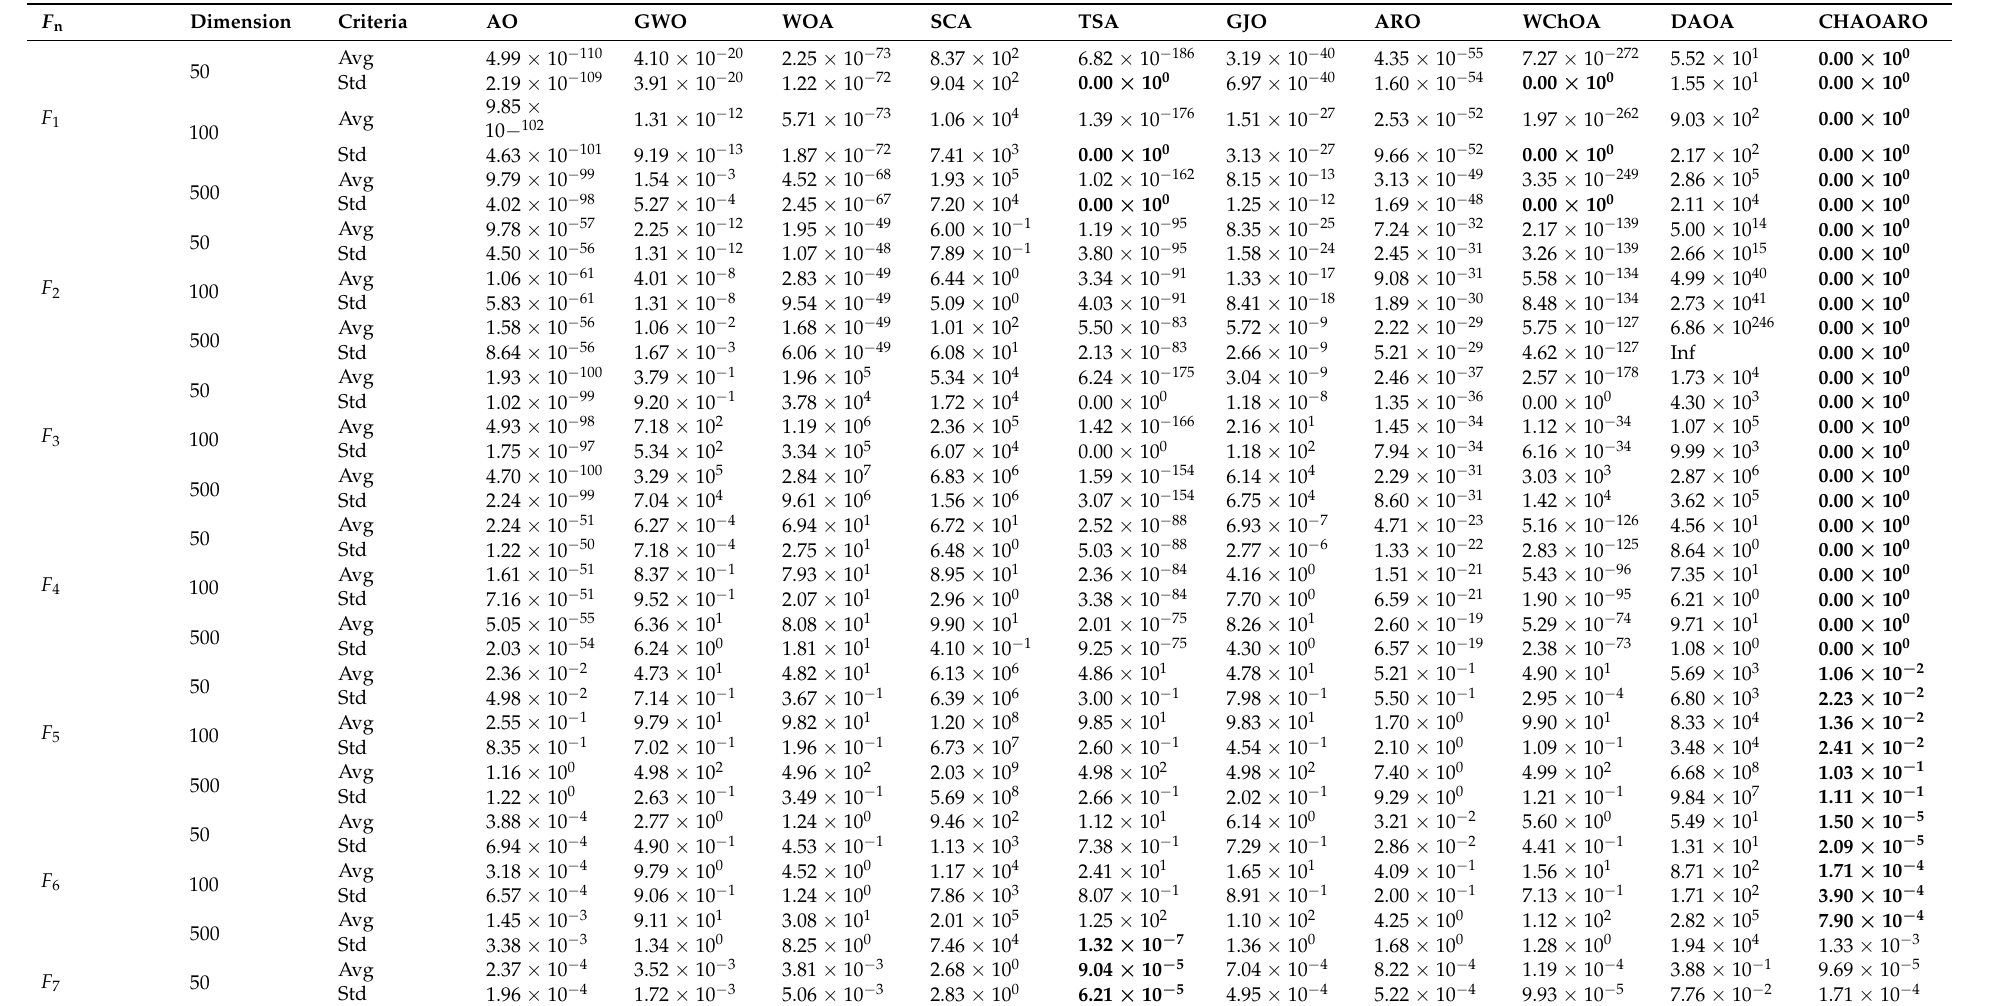
Table 9. Comparison results of CHAOARO and other algorithms on 13 unimodal and multimodal benchmark functions in different dimensions. F n Dimension